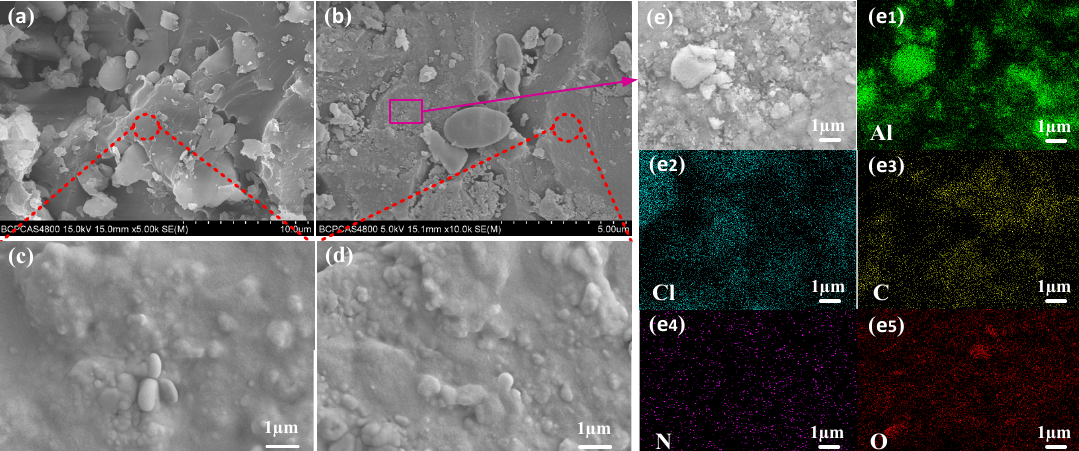
Figure 9. SEM images of the cross-section of the 3D-printed grain: ( a , b ) the micro-topography of the cross-section of the grain; ( c , d ) a further detail of the micro-topography of the cross-section of the grain; ( e ) SEM images of a further detail of the cross-section of the grain; ( e1 – e5 ) EDS images of Al, Cl, C, N and O elements in ( e ).